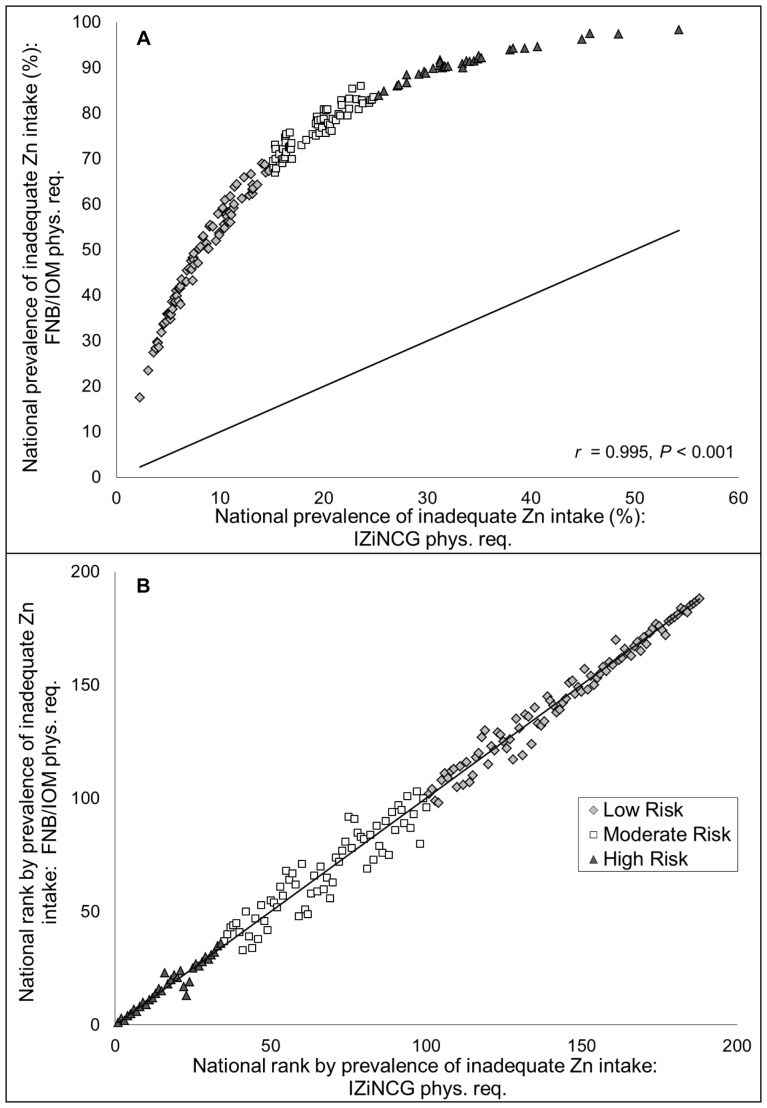
Associations between the (A) national prevalence and (B) country-specific rank order by prevalence of inadequate zinc intake as estimated by different physiological requirements.Estimates are based on the physiological requirements developed by the International Zinc Nutrition Consultative Group (IZiNCG) and the Food and Nutrition Board of the Institute of Medicine (FNB/IOM). The composite nutrient database, the Miller equation for absorbed zinc and a 25% inter-individual CV in intake are used for all estimates. The solid line represents the line of identity (intercept = 0, slope = 1). N = 188 countries. Country rank orders were assigned in descending order, with the country with the highest estimated prevalence of inadequate zinc intake having the lowest rank.